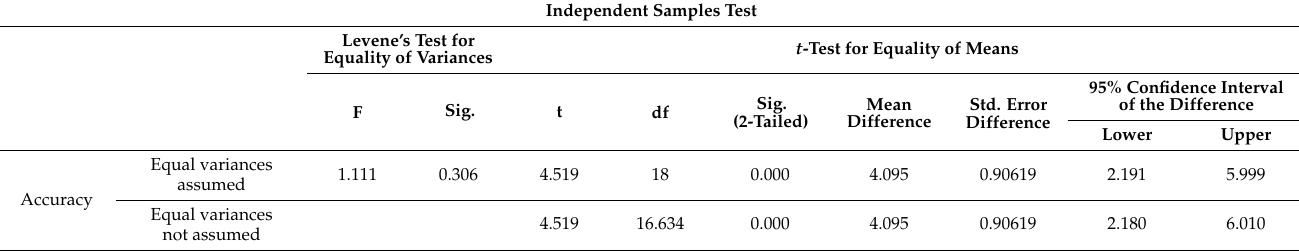
Table 6. Comparison of the independent sample t -test parameters of EDRL and CNN